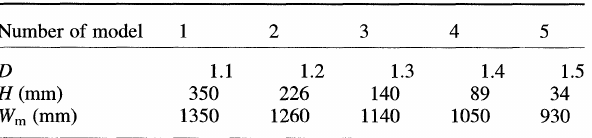
Simulation of drop height of steps of fault’s two sides and the maximum subsidence Number of model